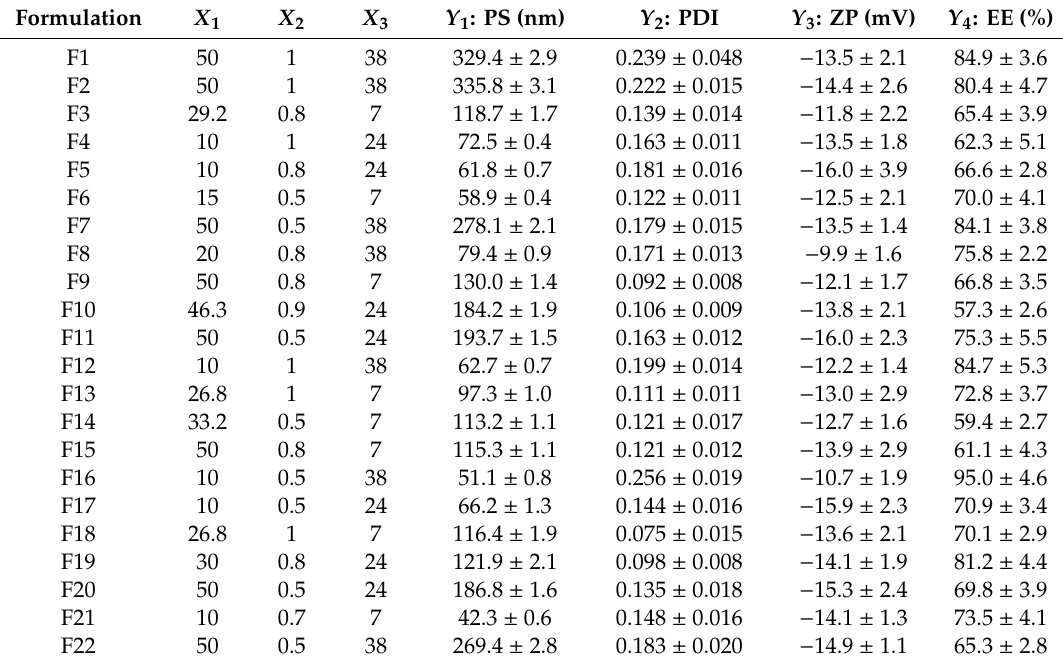
Table 2. Experimental design and measured responses for the optimization of